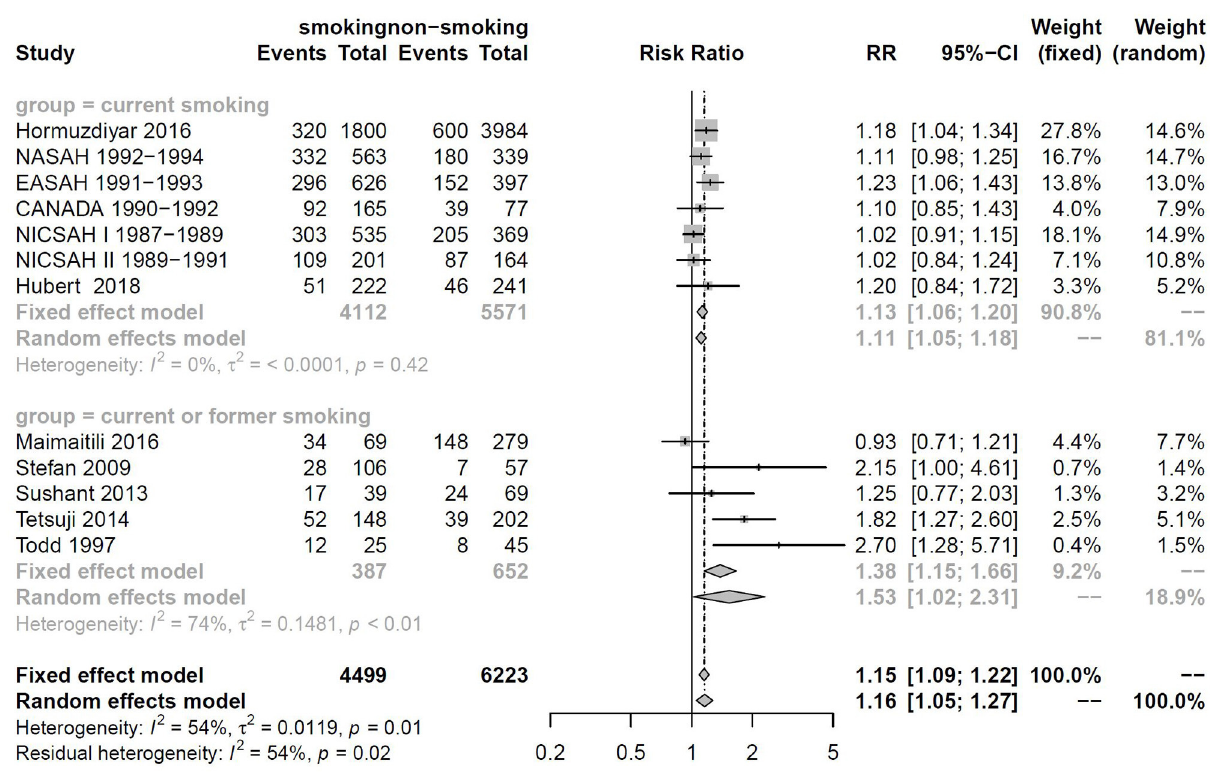
FIGURE 4 | Forest plot of subgroup analysis by smoking